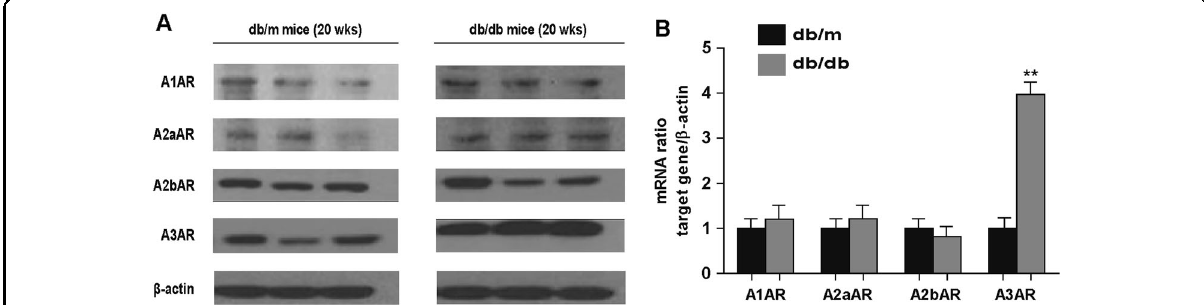
Fig. 1 db/db mice presented higher expression of renal A 3 AR than db/m mice. Mice were sacri fi ced at 20 weeks old, and kidney tissues were collected to analyze the expression levels of A 1 AR, A 2a AR, A 2b AR, and A 3 AR. ( a ) Protein and ( b ) mRNA expression levels of all AR subtypes are shown. Data are presented as the mean ± SE of 7 – 10 mice/group. ** p < 0.01 vs. db/m mice